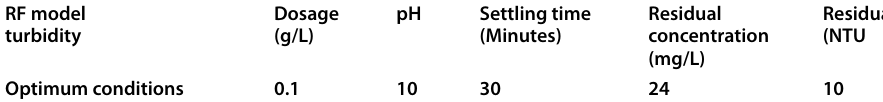
Theoretical sedimentation tank